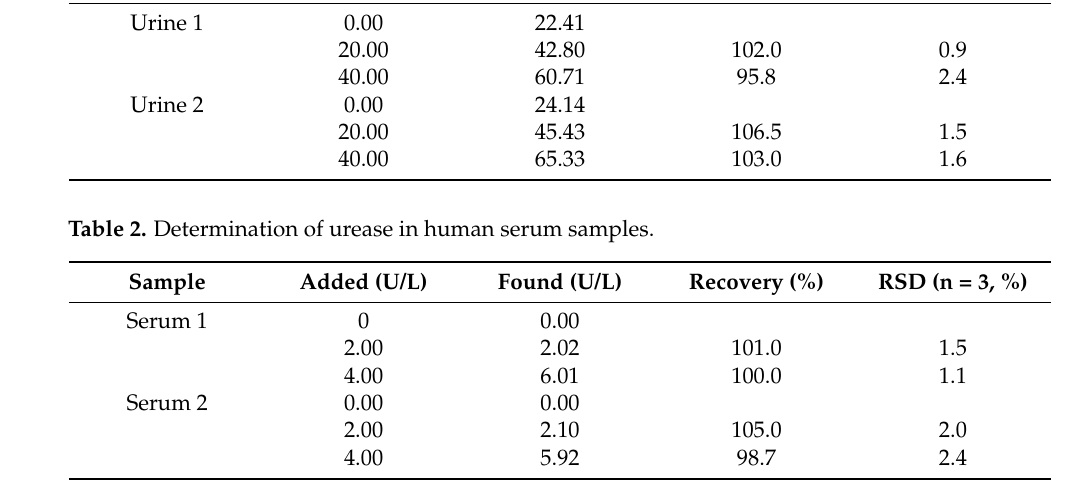
Table 2. Determination of urease in human serum samples.